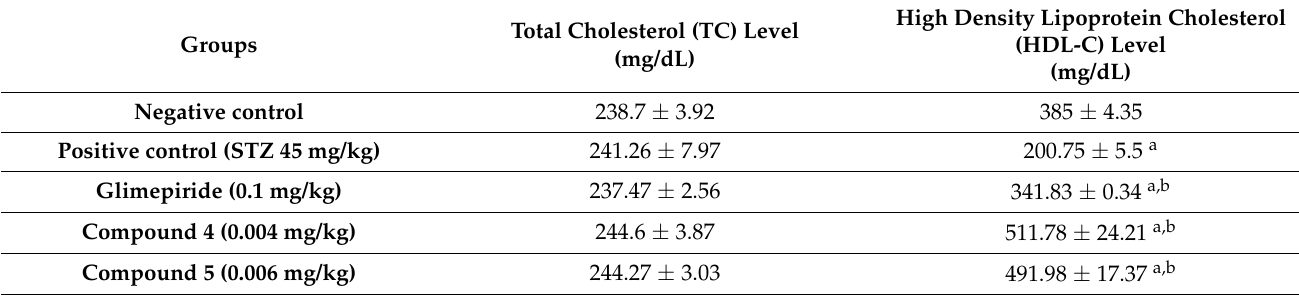
Table 2. Effects of compounds 4 and 5 on the serum lipid profile of STZ diabetic